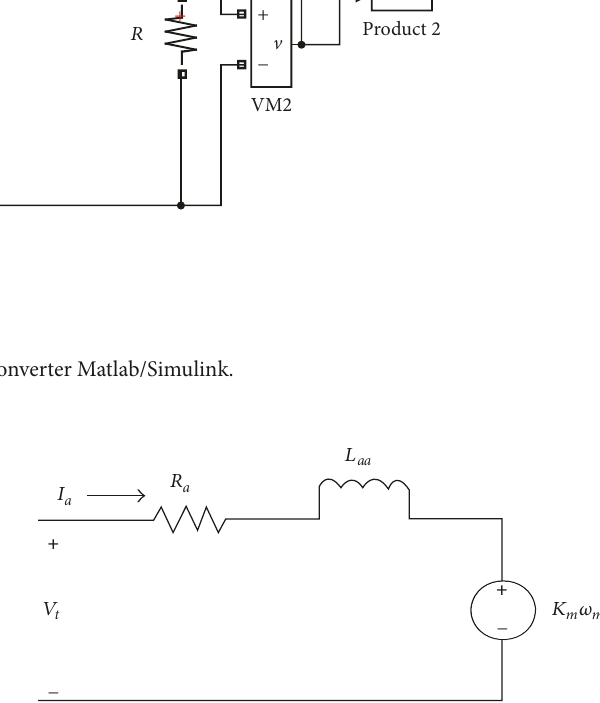
Figure 12: Equivalent circuit of a permanent magnetic DC